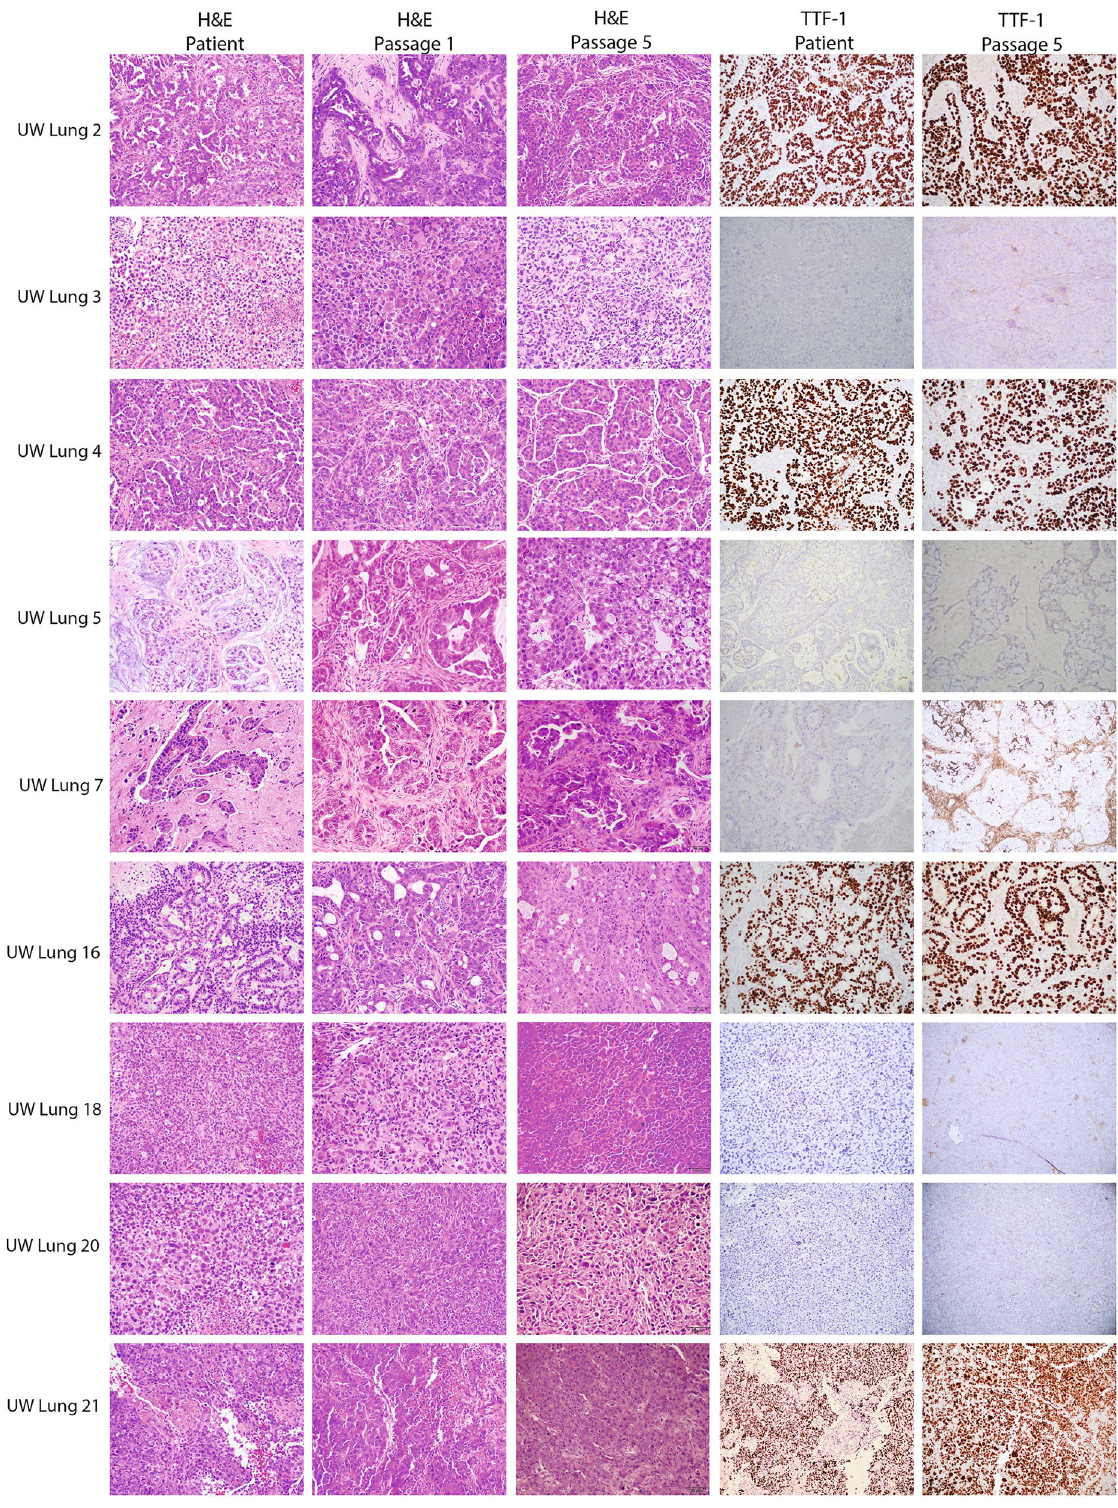
Figure 2. Histopathologic features of nine patient non-small cell lung cancer (NSCLC) brain metastases and corresponding NSCLC brain metastasis patient-derived xenografts (PDXs). Shown are photomicrographs hematoxylin and eosin (H&E) of patient tumor, PDX passage 1 and passage 5 and thyroid transcription factor-1 (TTF-1) of patient tumor and passage 1. Images at